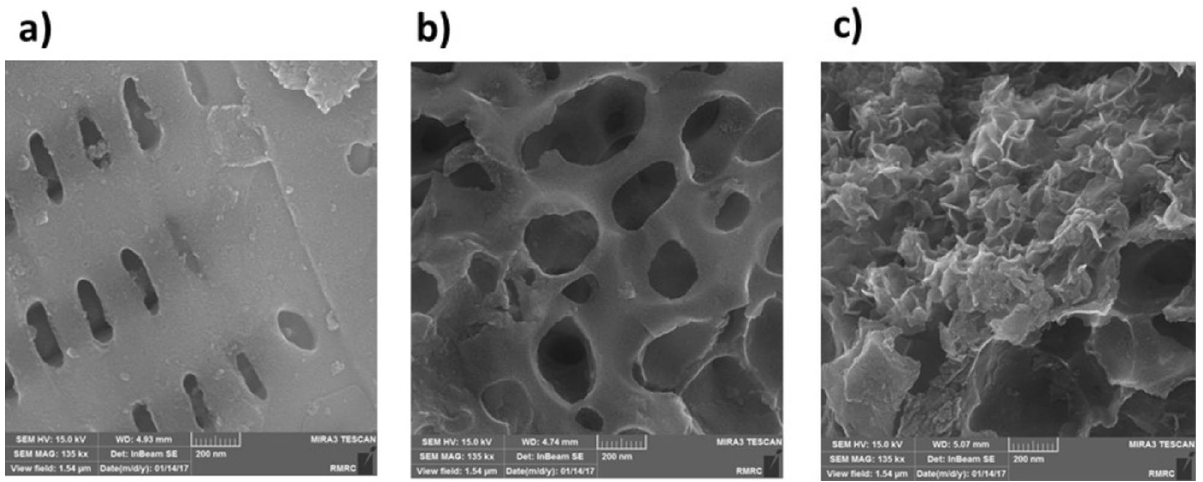
Figure 3. FESEM images of the RAB ( a ), 3DFAB ( b ), and CoTLM ( c ).